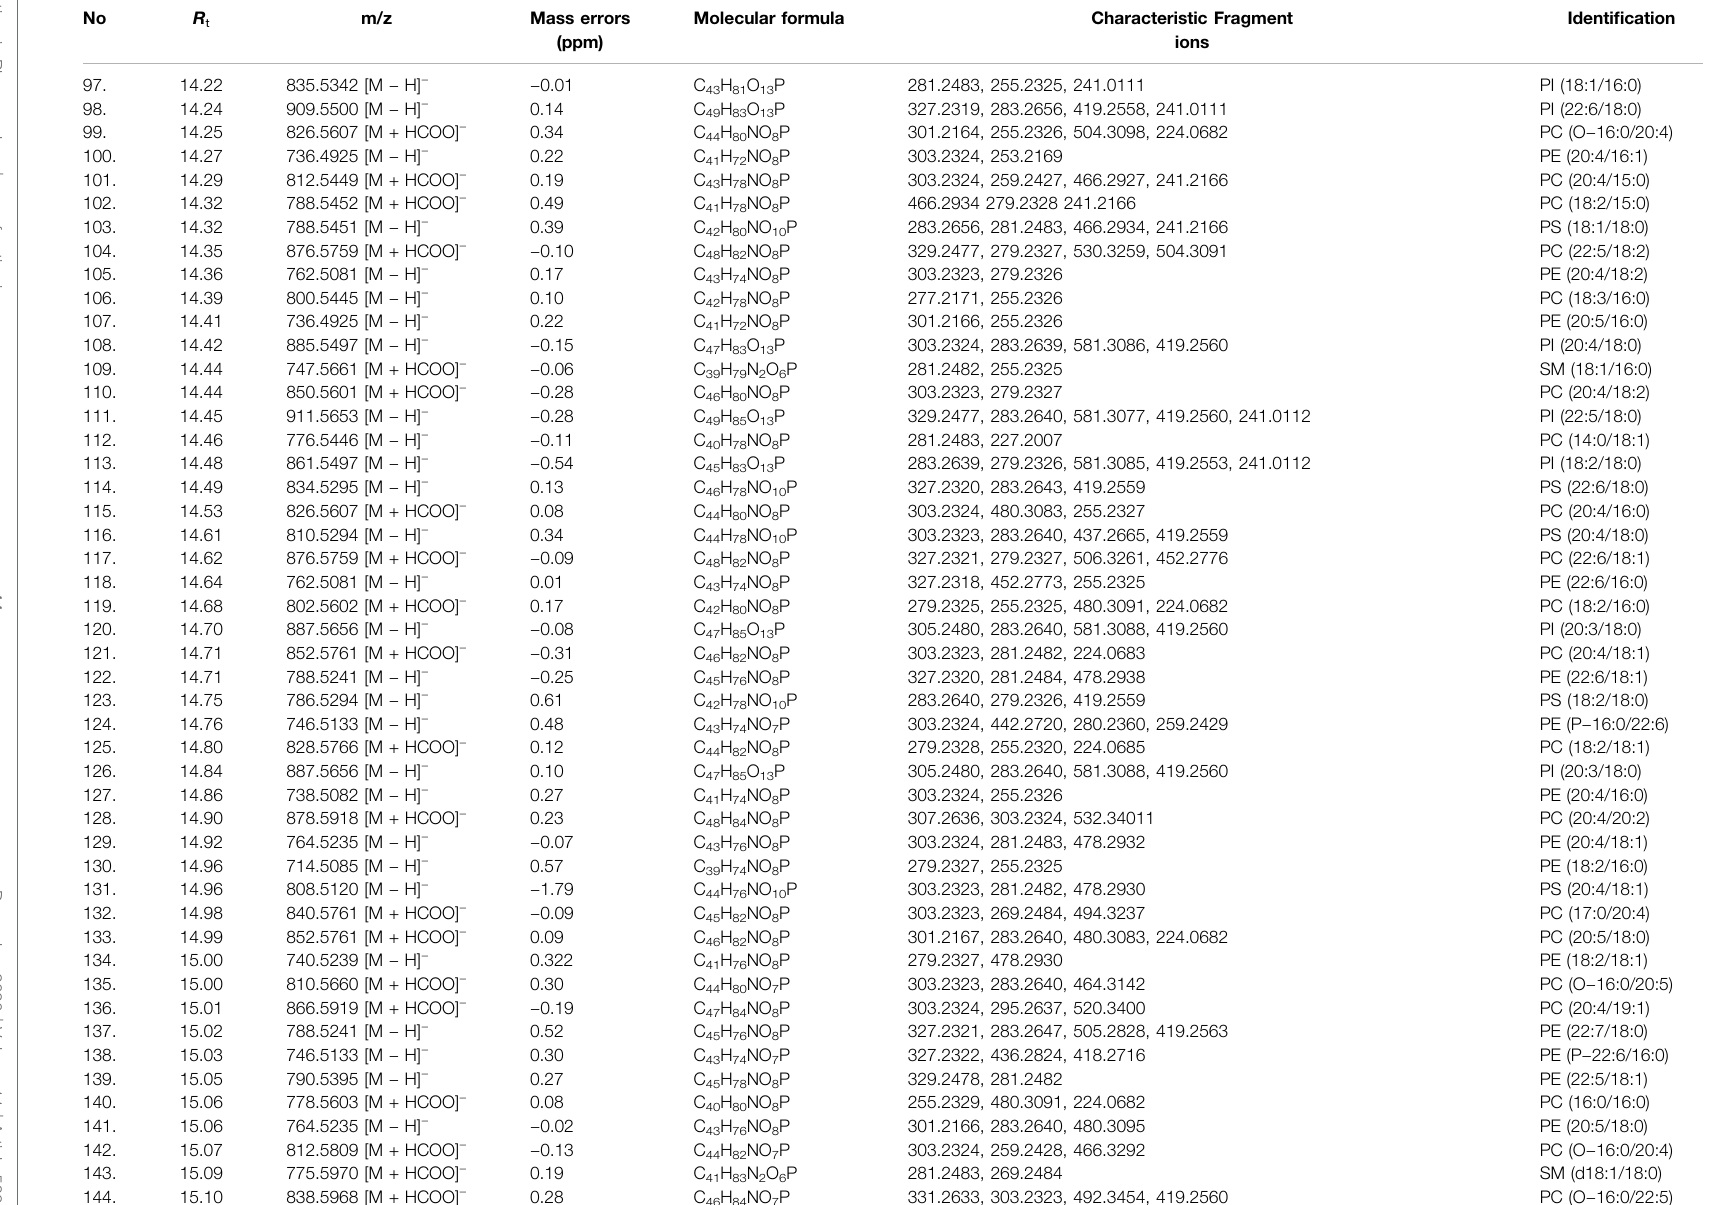
TABLE 2 | ( Continued ) The detected and tentatively identi fi ed lipid molecules in the rat liver. No R